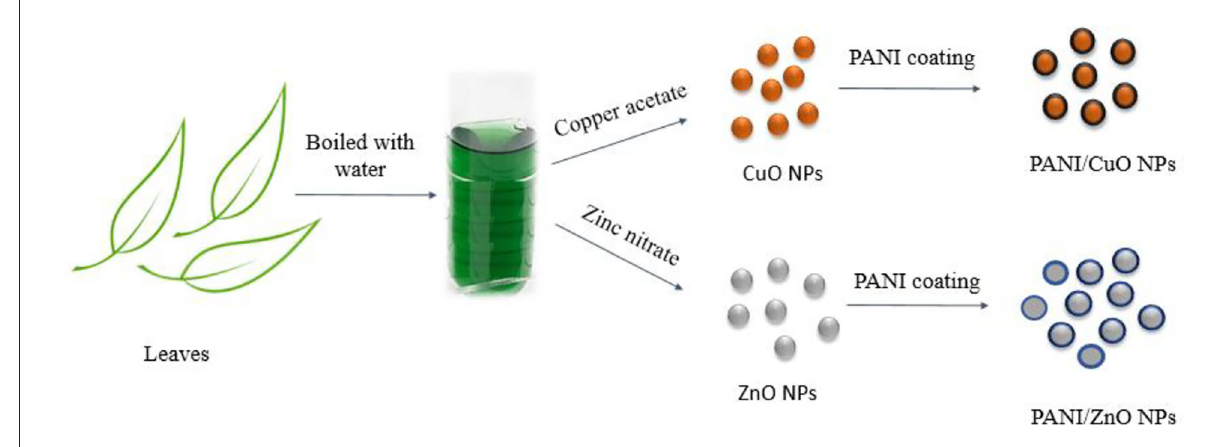
FIGURE2 Schematic representation of NPs’